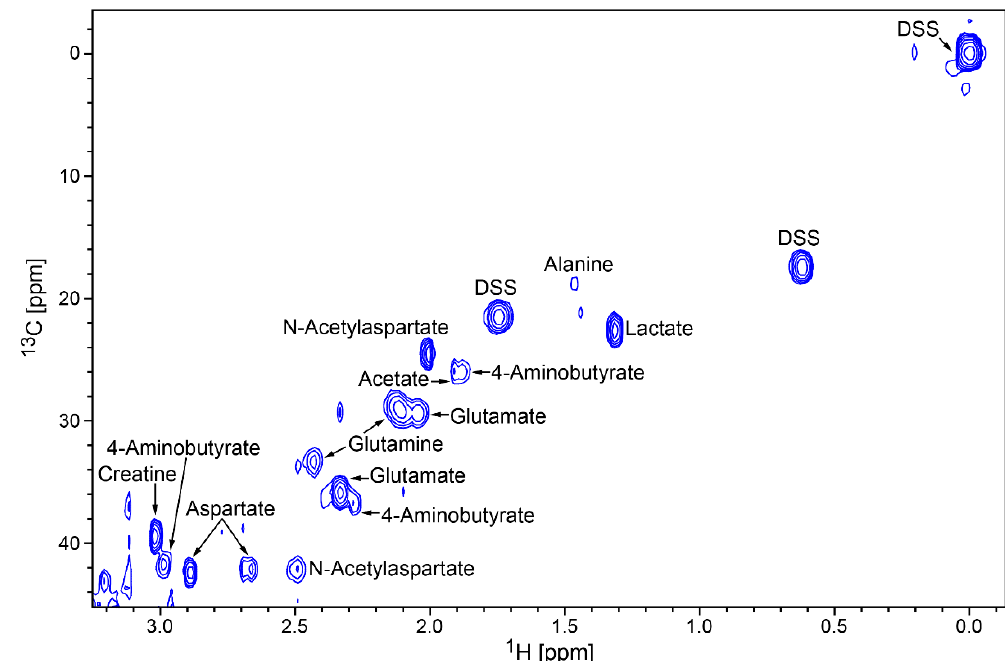
Figure 3. Subset of metabolites identified in the uncrowded region of the 2D 1 H, 13 C heteronuclear single-quantum correlation (HSQC) spectrum of synaptosomes obtained from control animals. The complete spectrum is provided in the supplementary material (Figure S1).